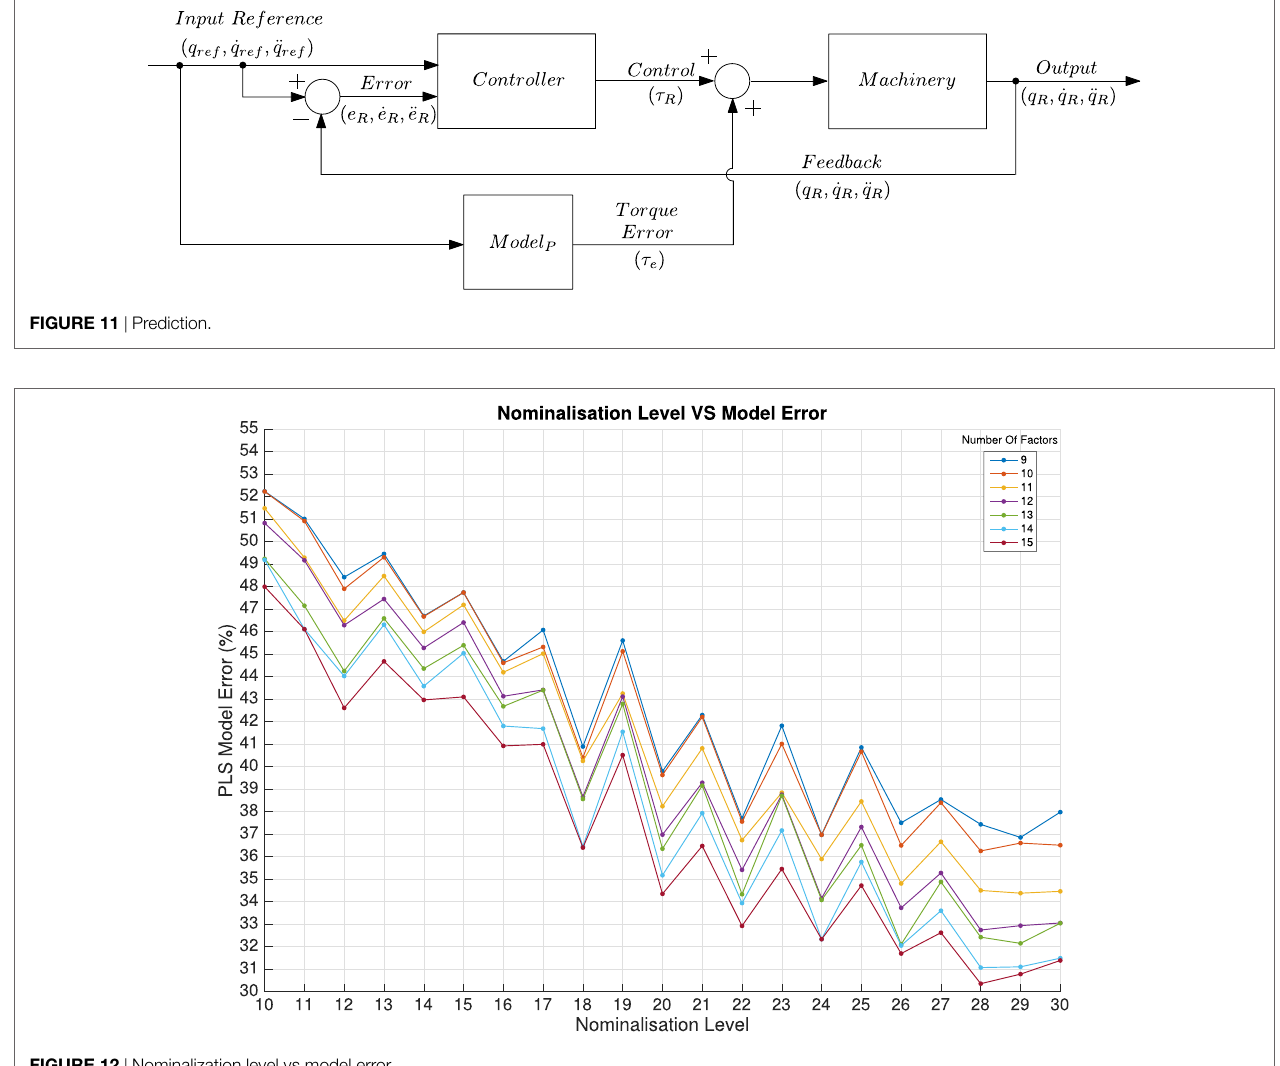
FIGURE 12 | Nominalization level vs model